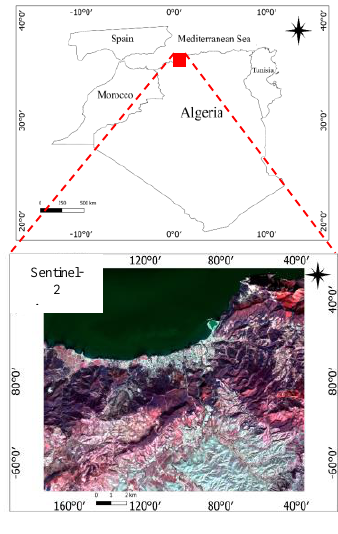
Figure 1 : Study area